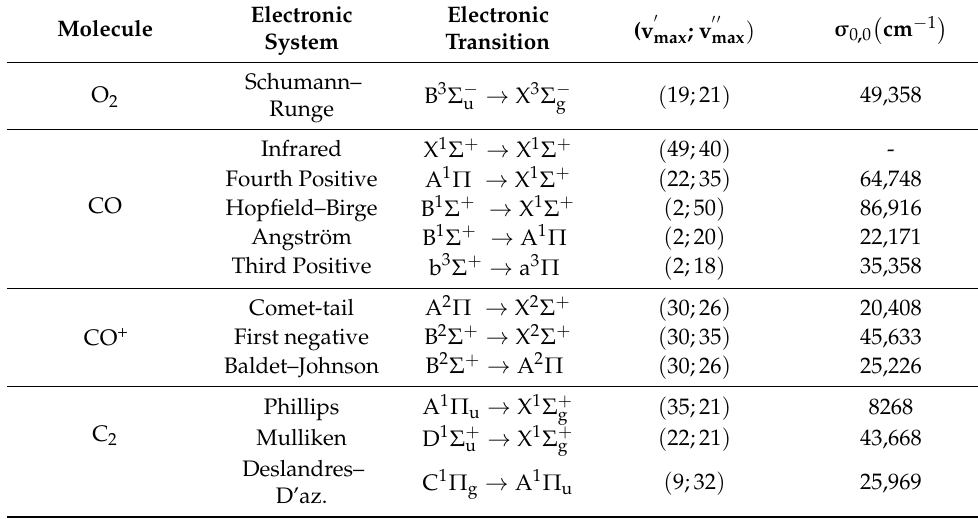
Table 3. Molecular band systems taken into account in the present